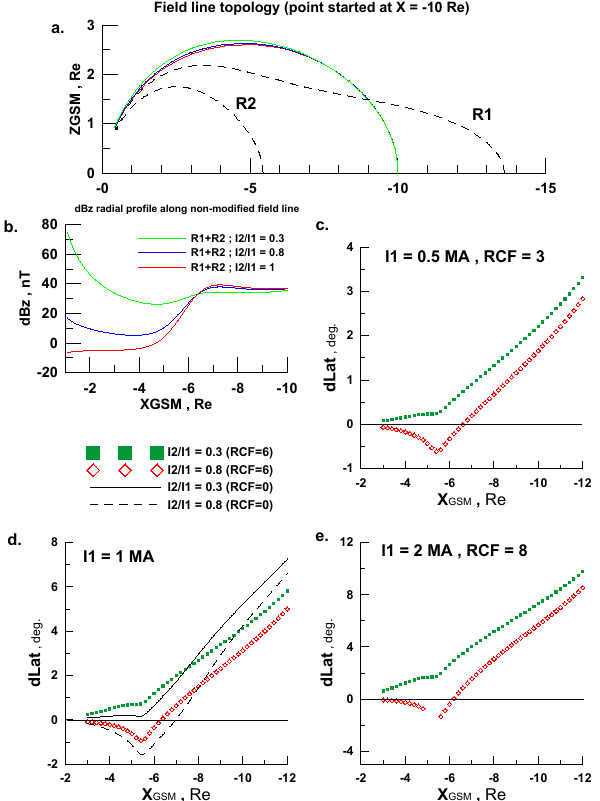
Figure 5. Parameter dependence of footprint displacement. (a) The X 0 Z plane projection of SCW2L FACs (dashed lines) and mag- netic field line traced from X =− 10Re; (b) (cid:49)B Z generated by SCW2L ( I 1 = 1MA) along the T89 magnetic field line start- ing at X =− 10Re; (c) latitudinal shifts for weak substorms ( I 1 = 0.5MA, RCF = 3); (d) same panel for strong events with two different magnetotail stretches ( I 1 = 1MA, RCF = 0 and 6); (e) same as (c) and (d) but calculated for extremely strong sub- storms ( I 1 = 2MA, RCF = 8). Different colors in panels (c–e) cor- respond to the same I 1 but with two values of the I 2 /I 1 current ratio, shown in green for I 2 /I 1 = 0.3 and in red for I 2 /I 1 = 0.8. All calculations are done for the fixed RT 1 = 15Re, RT 2 = 6Re, wedge azimuthal width of 50 ◦